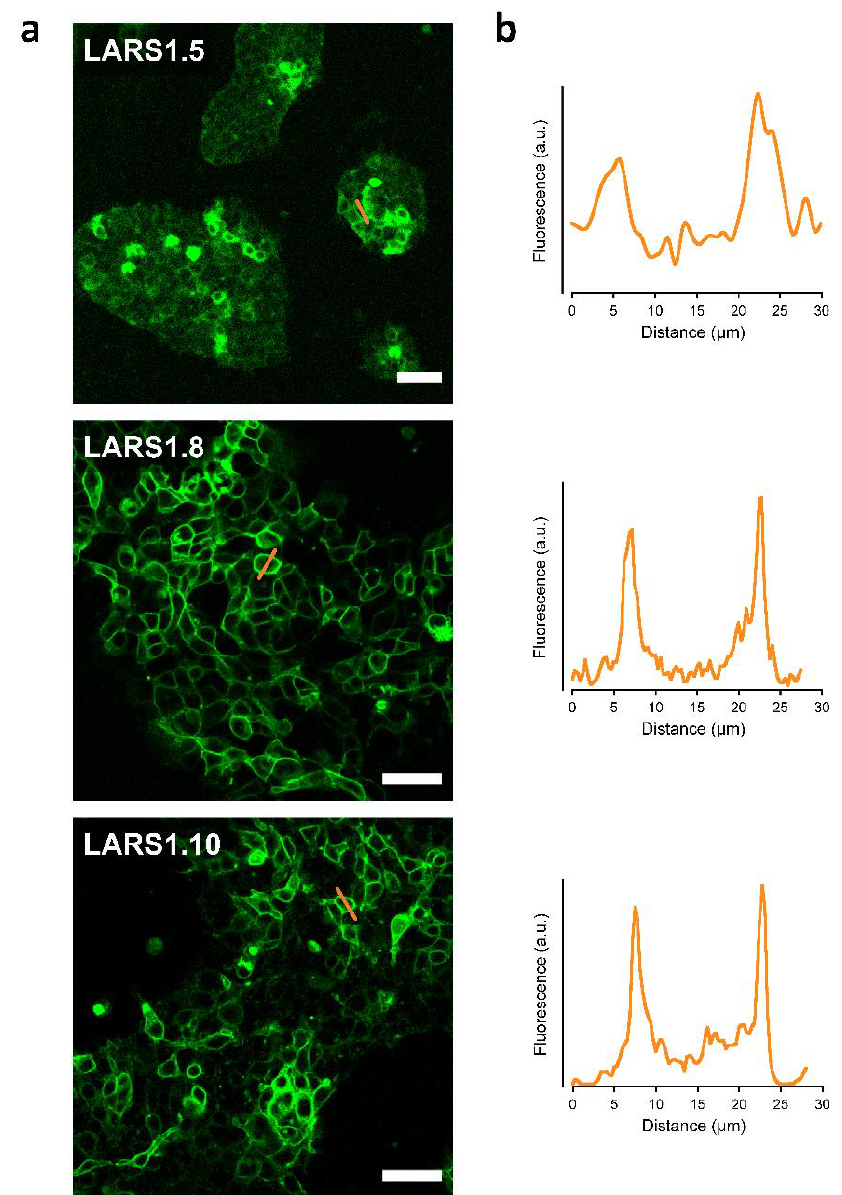
Figure 1. Cellular expression of candidate biosensors in HEK293 cells. Confocal images of live HEK293 cells transfected with LARS1.5, LARS1.8, and LARS1.10 and observed 48 h after transfection. Images show endogenous cpGFP fluorescence (λ ex = 488 nm) ( a ). A representative profile plot across cells (at sites indicated by orange lines in left panel) is shown next to the candidate biosensors ( b ). Scale bar, 50 µm.